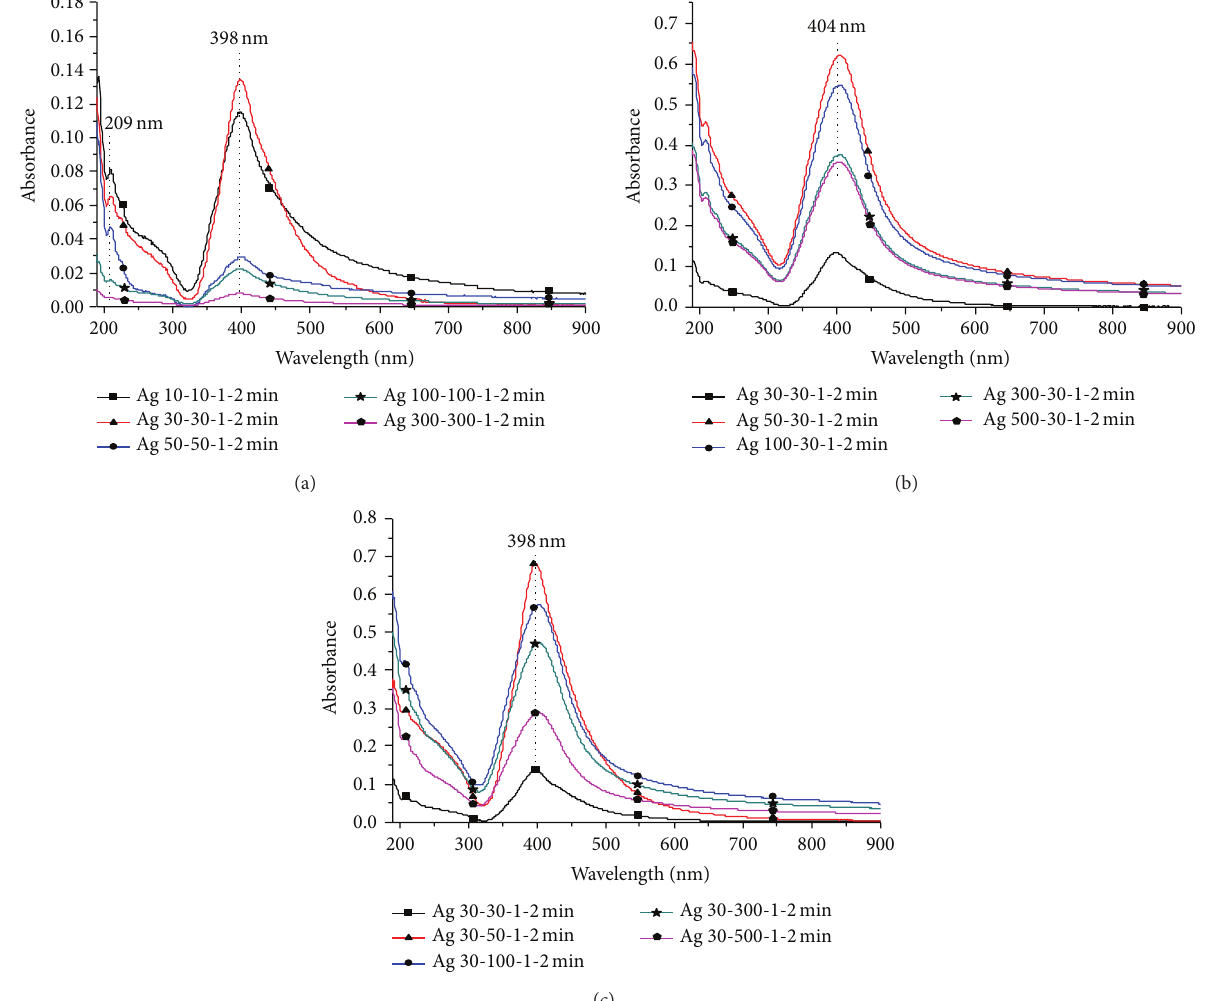
Figure 3: Silver fluid UV-V analysis results: (a) 𝑇 increase.